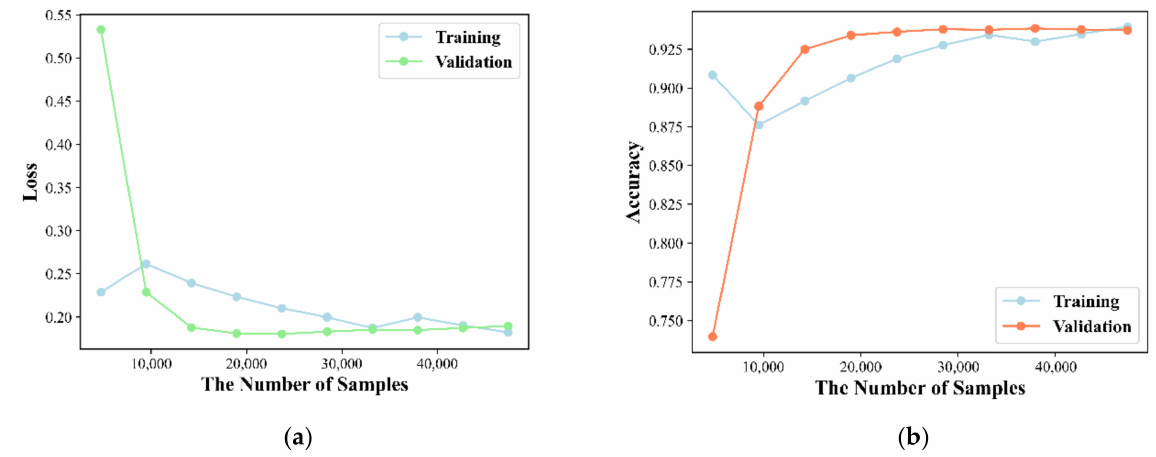
Figure 2. The learning curve of our method. ( a ) Training and validation accuracy graph; ( b ) Training and validation error